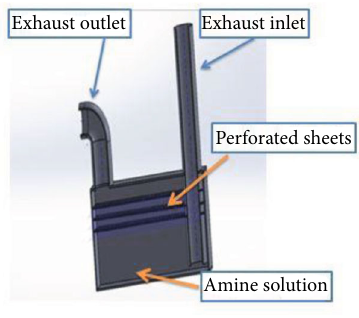
Figure 3: Design of CO